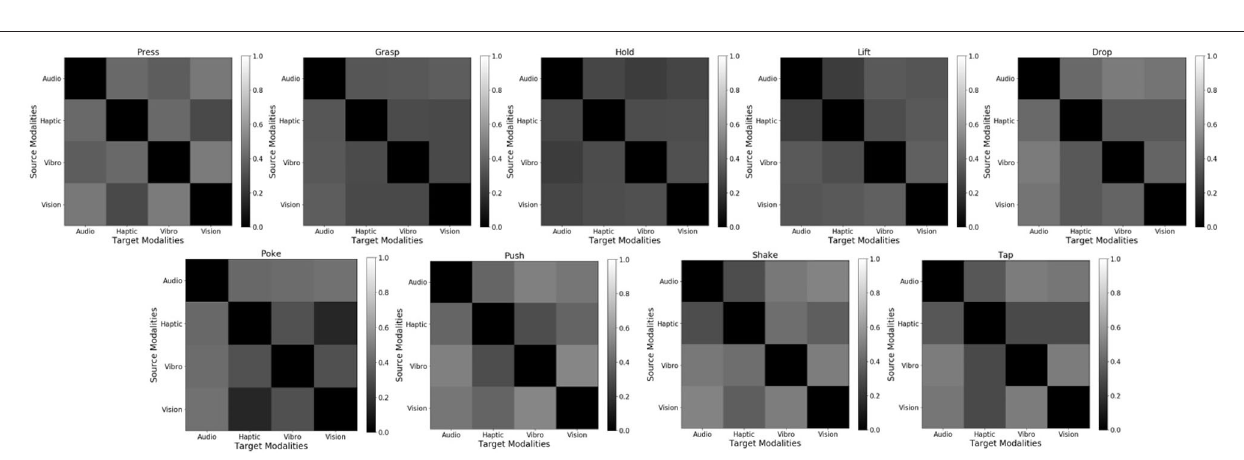
FIGURE 12 | Cross-perception Accuracy Delta for 9 behaviors using β -VED. From top to bottom and from left to right: (1) press , (2) grasp , (3) hold , (4) lift , (5) drop , (6) poke , (7) push , (8) shake , and (9) tap . Darker color means lower Accuracy Delta (better) and lighter color means higher Accuracy Delta